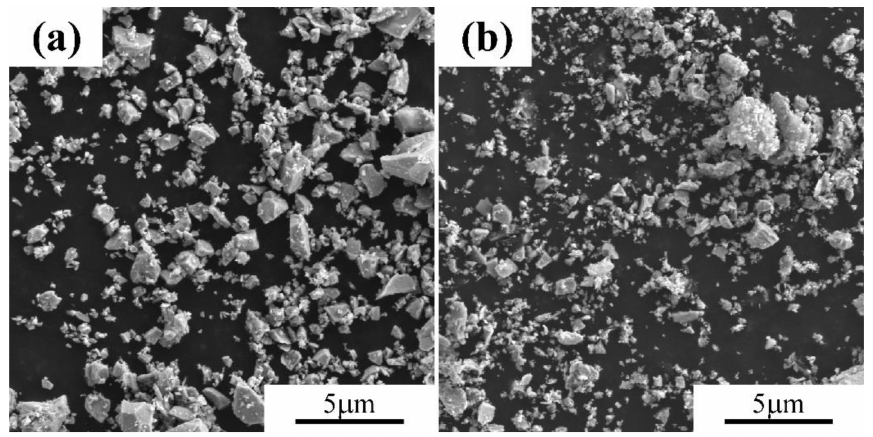
Figure 1. SEM images of powders: ( a ) (Ti,W)C powders, ( b ) (Ti,W)C-3Ta mixed powders. Table 1. Chemical composition of (Ti,W) C solid solution powders (wt.%). Cermet